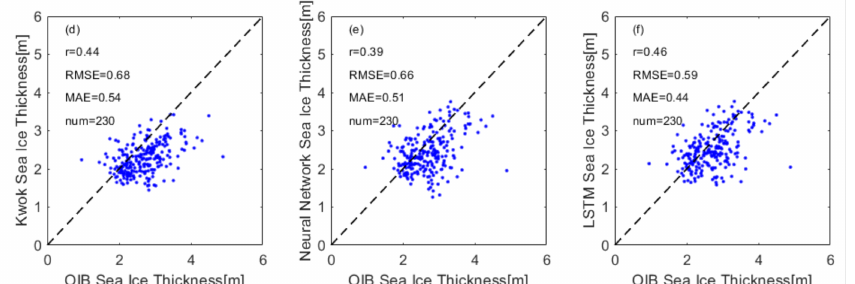
Figure 13. Evaluation of the CryoSat-2 (CS-2) SIT retrieved from different snow depths compared with the OIB sea ice thickness: ( a ) modified W99 snow depth, ( b ) AWI snow depth, ( c ) Bremen snow depth, ( d ) Kwok snow depth, ( e ) Neural Network snow depth and ( f ) LSTM snow depth. The black line is the relationship with each